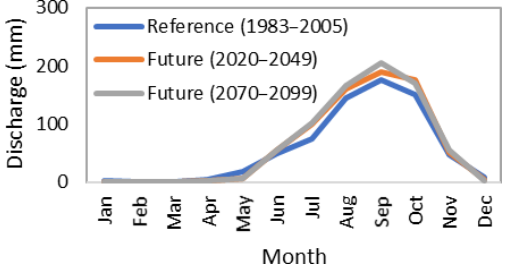
Figure 4. Change in the annual discharge pattern (CORDEX